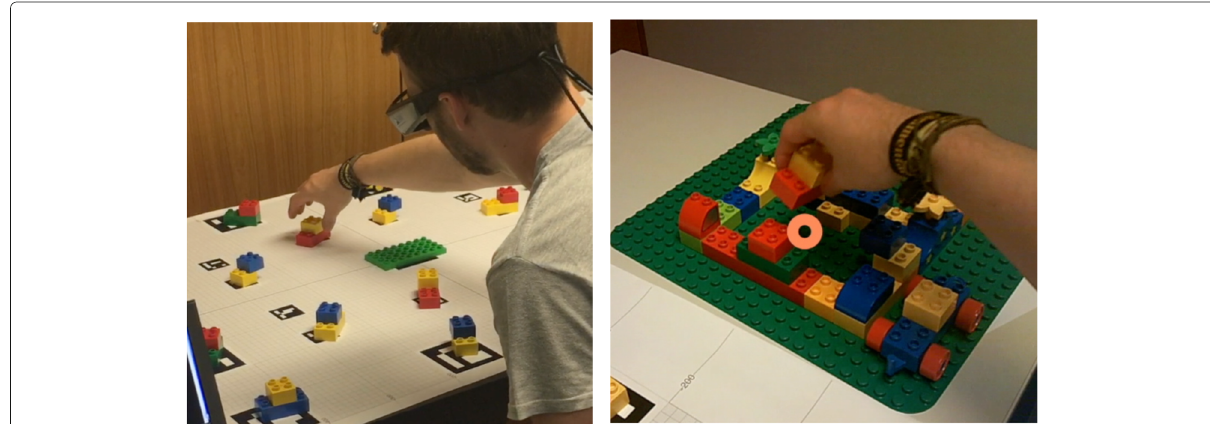
Fig. 2 An example trial. The system instructs the user with an instruction possibly supplemented with verbal feedback. The listener identifies and grasps the target (left), which is assembled onto the other LEGO blocks (right). The circle represents the gaze cursor (not visible to the